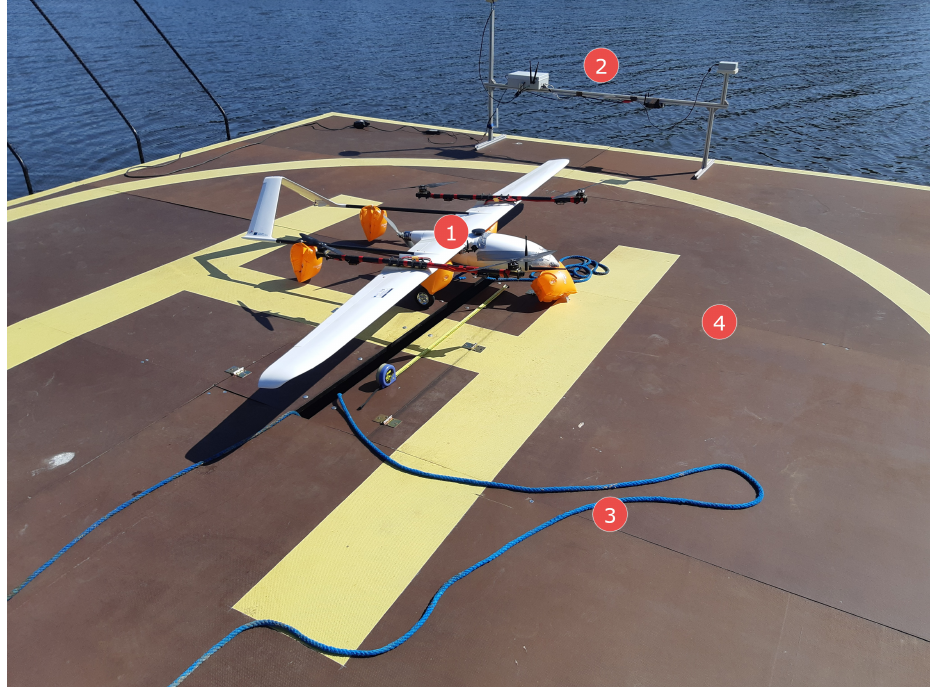
Figure 5. Albatross VTOL on a floating landing pad during lake tests, 1—Albatros VTOL UAV, 2—the landing pad navigational station, 3—a safety rope, 4—the landing